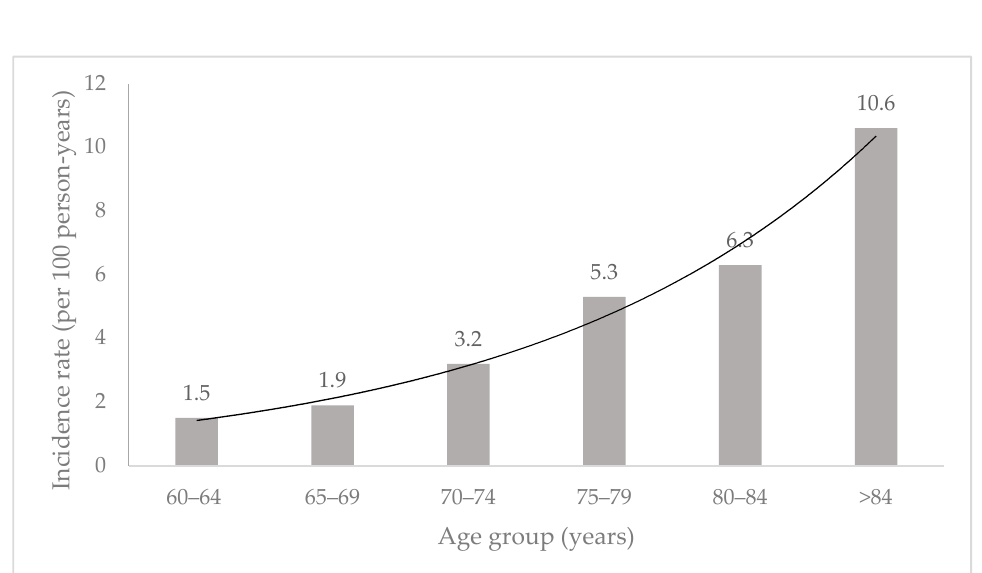
Figure 2. The age-specific incidence rates and 95% confidence intervals of mortality events from 2013 to 2019. The incidence rate was computed for 5 age categories using a person-years analysis and was plotted at the age group: 60–64 years, 65–69 years, 70–74 years, 75–79 years, 80–84 years, and 85 years and above.